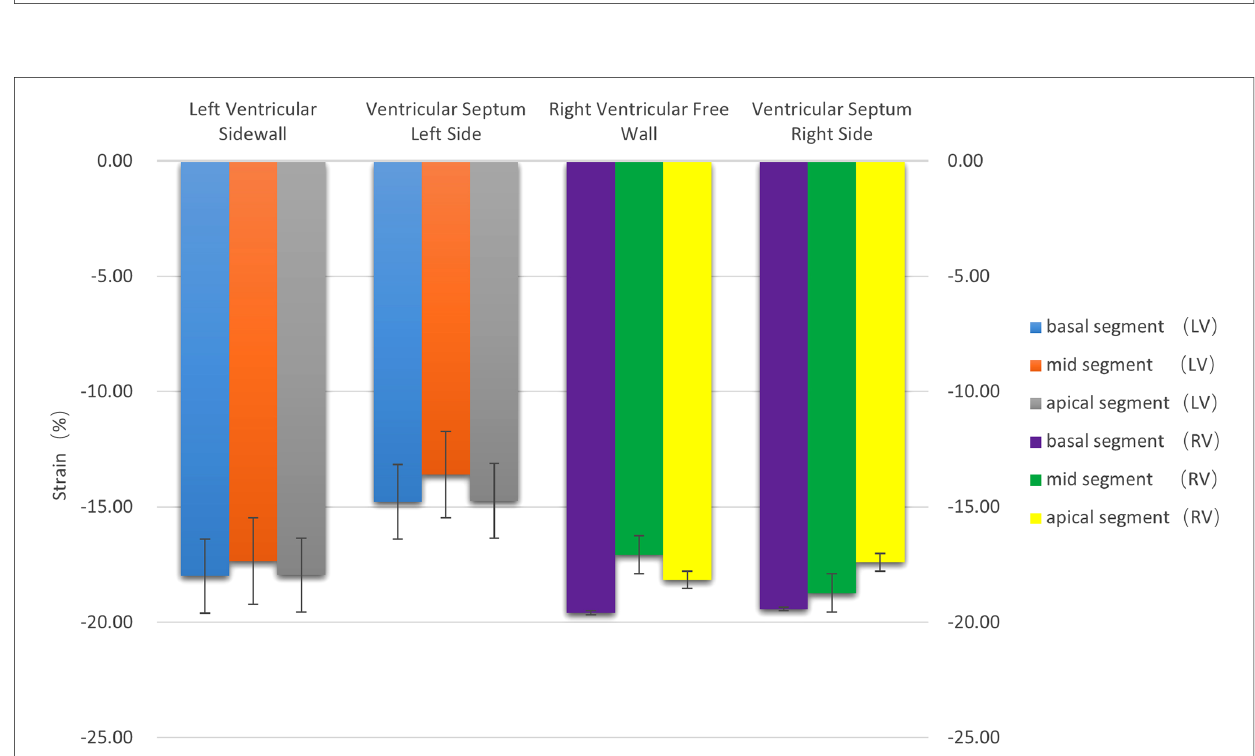
FIGURE 3 The histogram of the strain of the left and right ventricular walls at each segment. There were no statistically signi fi cant differences in the strain between the left and right ventricles ( P >0.05). The strain values were negative.